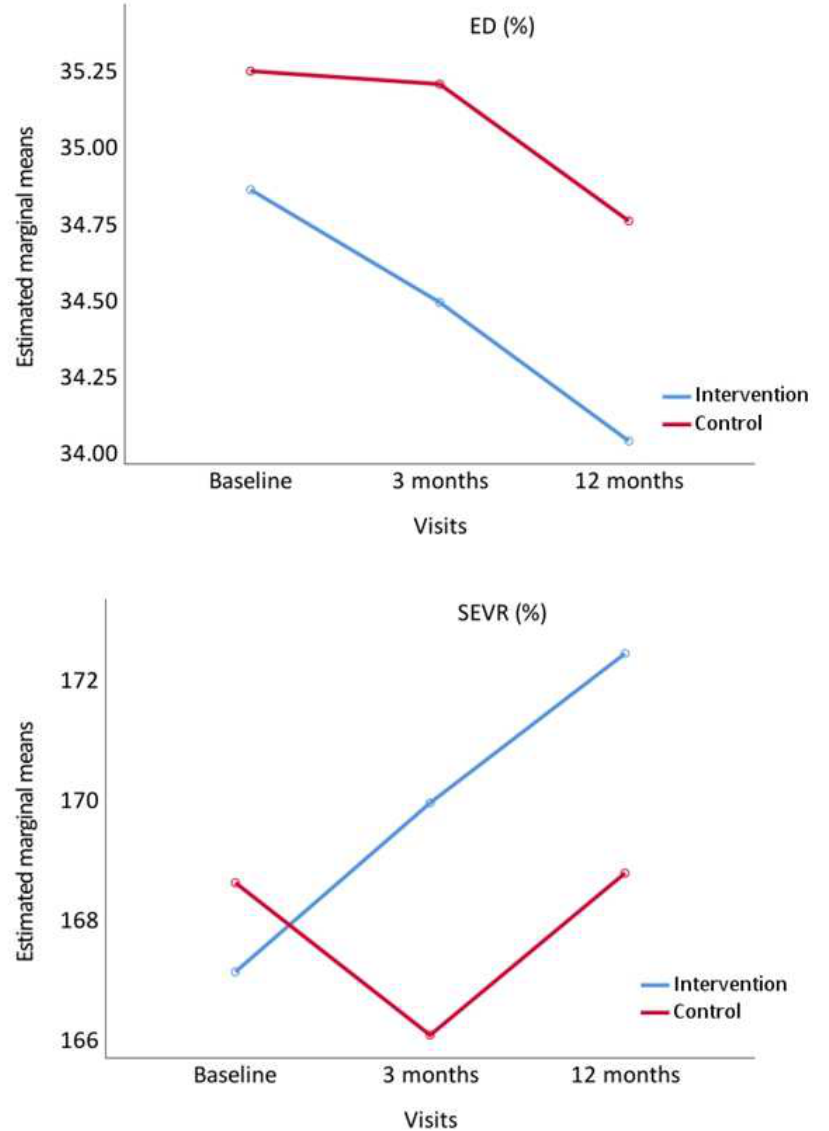
Figure 4. Evolution of augmentation pressure (AP), ejection duration ratio (ED%), and subendocardial viability ratio (SEVR%), from baseline to 3 and 12 months comparing the intervention and control groups. p value between groups: AP, p = 0.741; ED%, p = 0.276 and SEVR%, p = 0.583.